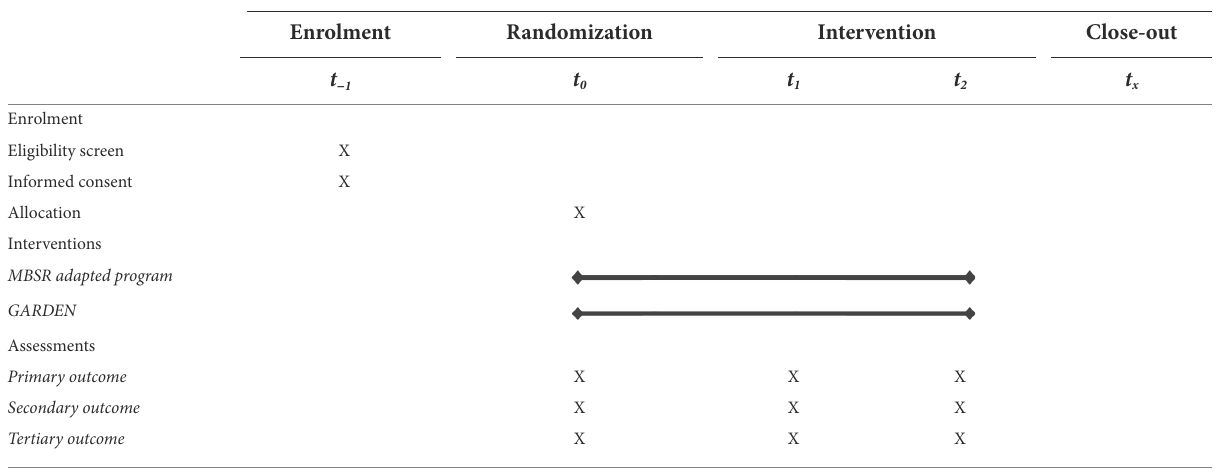
TABLE 1 Schedule of enrolment, interventions, and